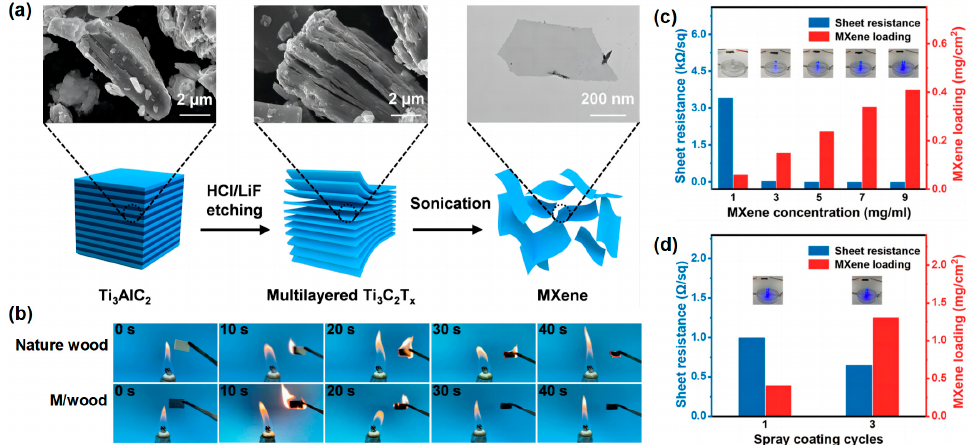
Figure 19. ( a ) Diagram of the preparation of the MXene sheets and the corresponding SEM images; ( b ) video screenshot of the burning process of natural wood and M/wood at various times. ( c ) The sheet resistivity of wood and MXene loading at various MXene concentrations. ( d ) The sheet resistivity of wood and the cycles of spray coating at various MXene concentrations; the M/wood electrical contact for LED lighting bulbs are seen in the picture [73].